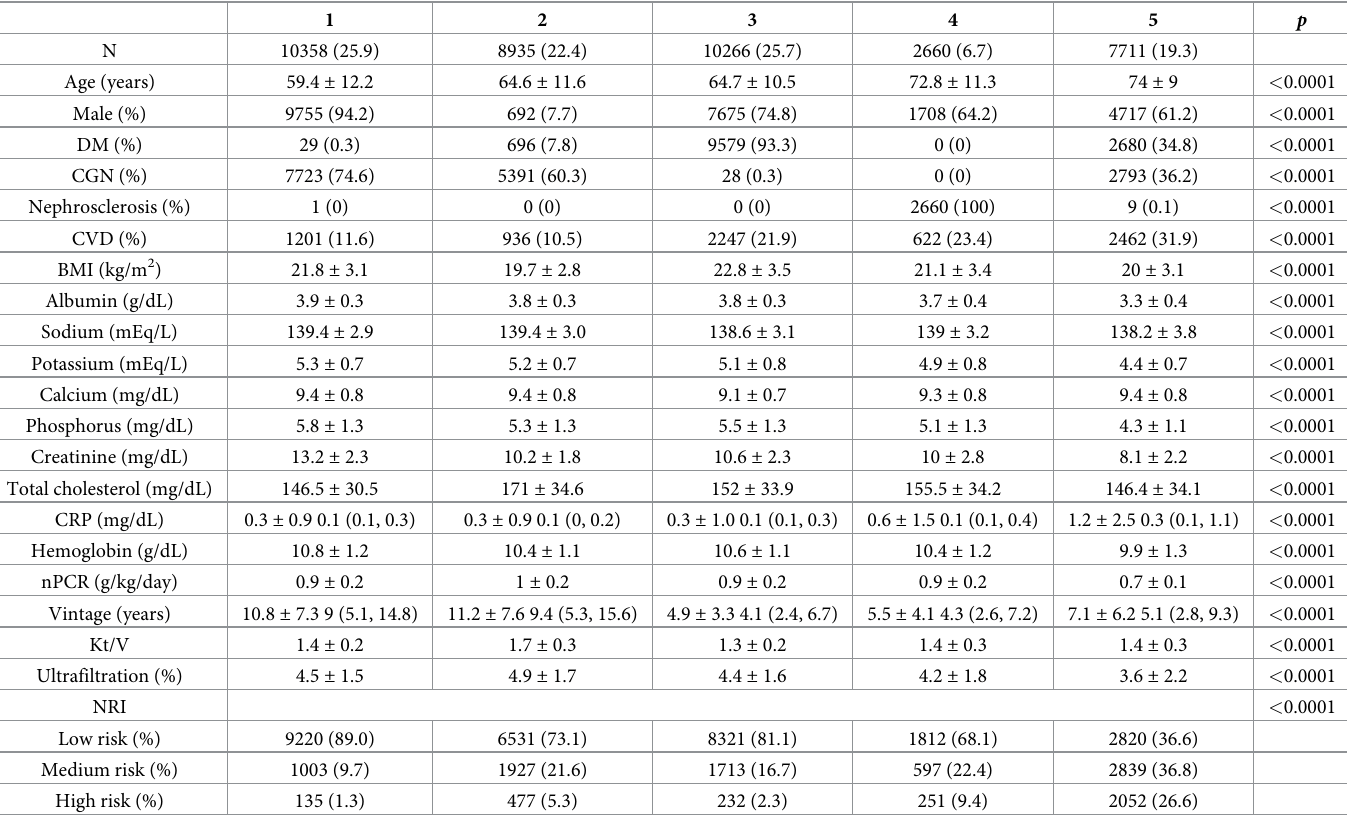
Table 4. Baseline characteristics of clusters in validation dataset.